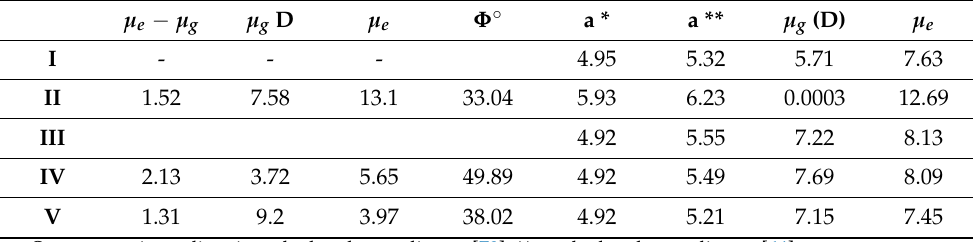
Table 3. Onsager Cavity Radii, a, (in Å), µ e , µ g dipole moments (D) of I –